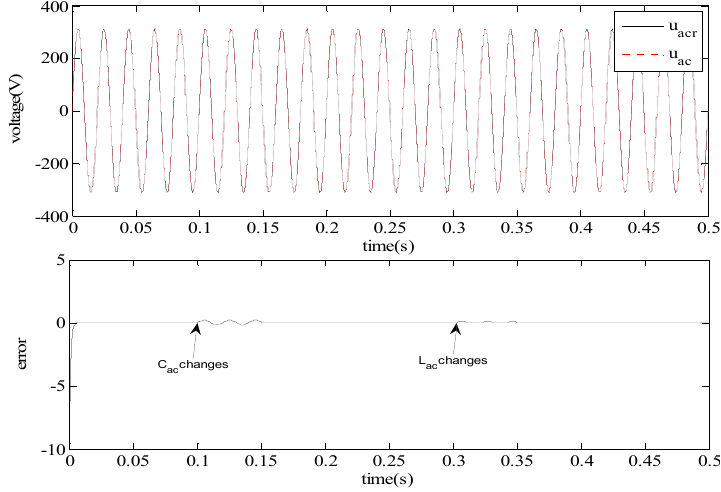
Figure 12. Performance of the inverter under parameter variations.